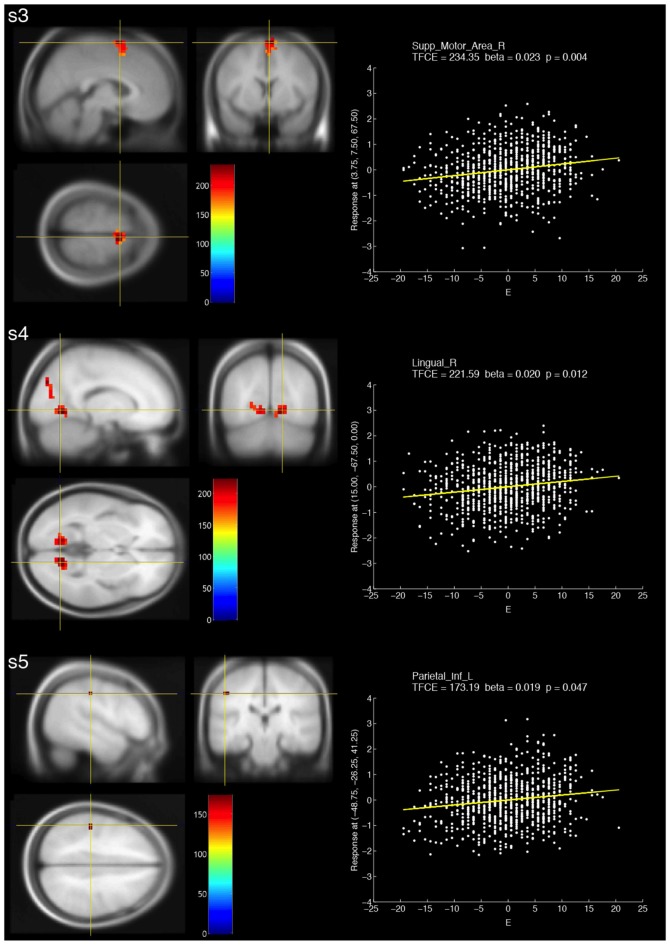
Brain areas that showed significant positive correlations with fractional amplitude of low-frequency fluctuation (fALFF) at three different frequency bands (s3: slow-3, s4: slow-4 and s5: slow-5) and extraversion scores (E). The resulting threshold-free cluster enhancement (TFCE) maps were thresholded with a voxel-wise significance of a family-wise error (FWE)-corrected p < 0.05 and overlaid on the avg305T1 template using SPM8. The color bar indicates the TFCE magnitude. The peak voxels for the three bands are marked by the yellow cross-hairs. Each scatter plot shows the relationship between the E score (minus the mean value) and fALFF at the peak voxel. The nuisance covariates were regressed out at the peak voxel. Each yellow line within the scatter plot shows the fALFF predicted from the E score.